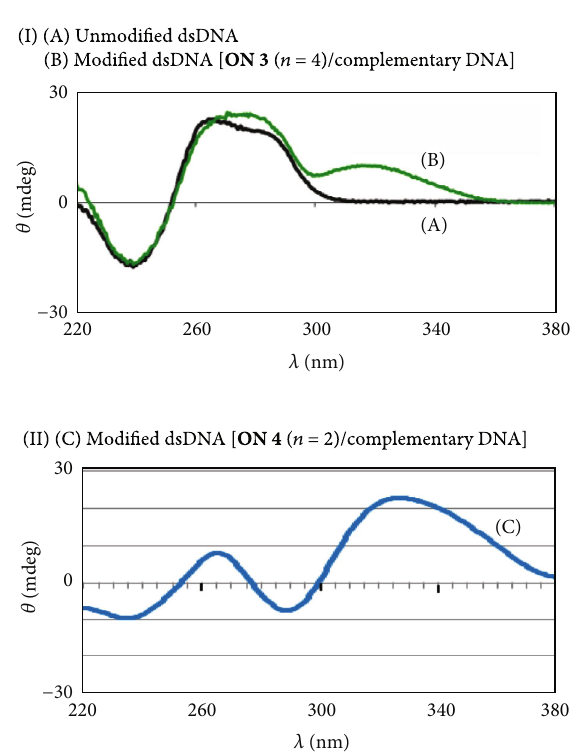
Figure 4: CD spectra of unmodi fi ed and modi fi ed dsDNAs. modi fi ed DNA: 5 ′ -d(CG G ACCCTGGC)- 3 ′ , ON 3 ( G =Im ON 4 ( G =Py